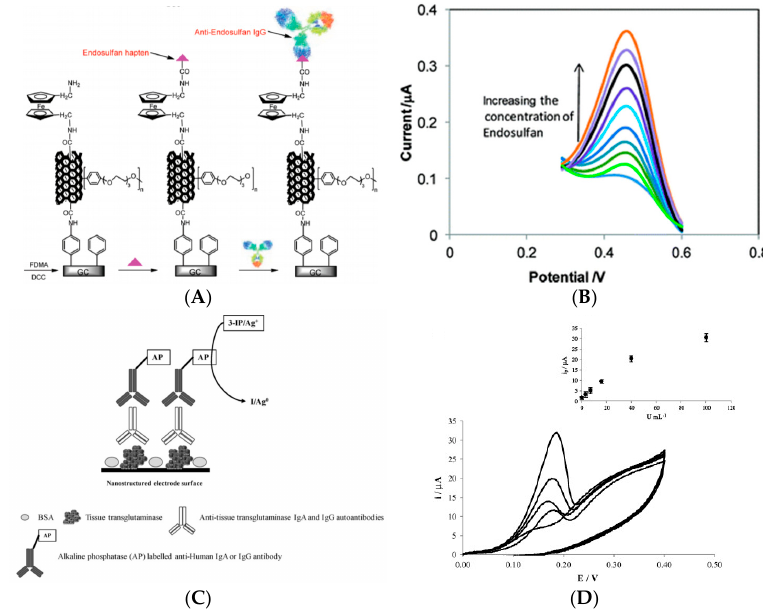
Figure 6. ( A ) SWNT-modified GC electrodes for detection of endosulfan; ( B ) SWVs for GC-Ph- NH 2 /SWNT/PEG/FDMA/endosulfan/anti-endosulfan electrode after incubation in with 0, 0.02, 0.05,